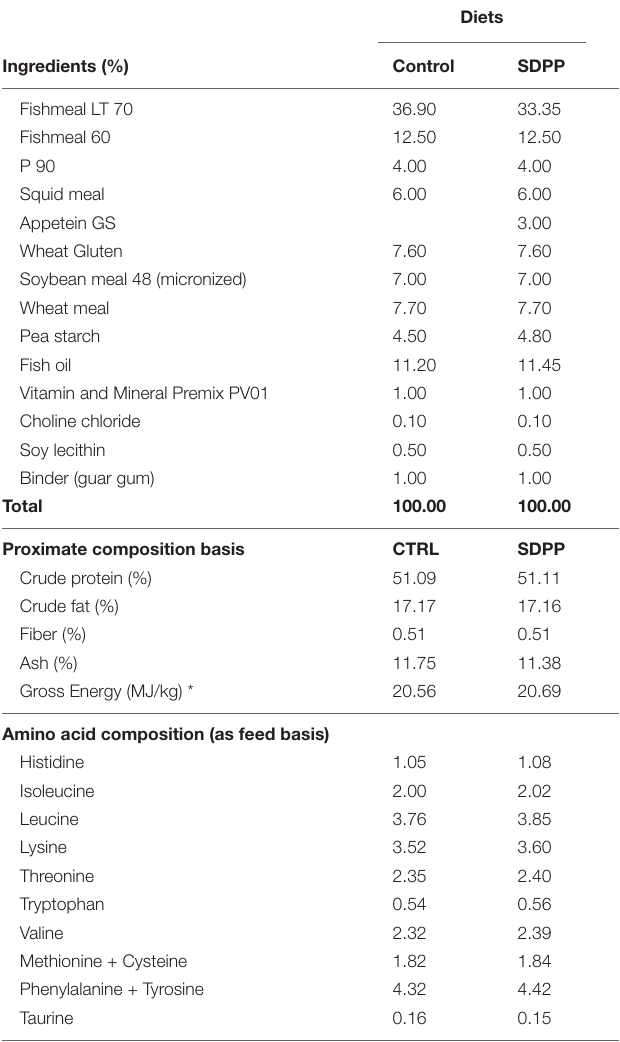
TABLE 1 | Ingredient list and proximate composition on a dry weight basis (%) of experimental diets.